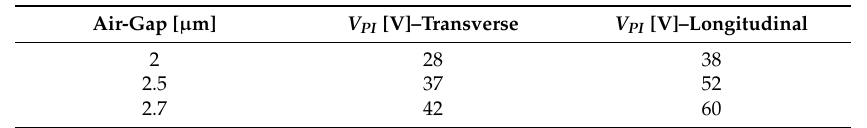
Table 2. Actuation (pull-in) voltage at di ff erent air-gaps for the transverse and longitudinal RF-MEMS membranes previously shown in Figure 2.